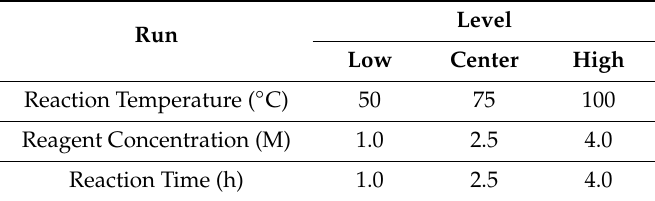
Table 1. Parameters for the leaching test and their corresponding levels.